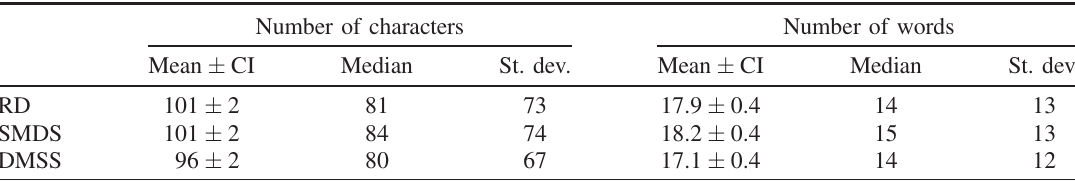
TABLE VI. The mean, median, and standard deviation (st. dev.) of the lengths of the written explanations to each probe. These lengths are calculated by the number of characters and by the number of words. The uncertainties on the means are 95% confidence intervals